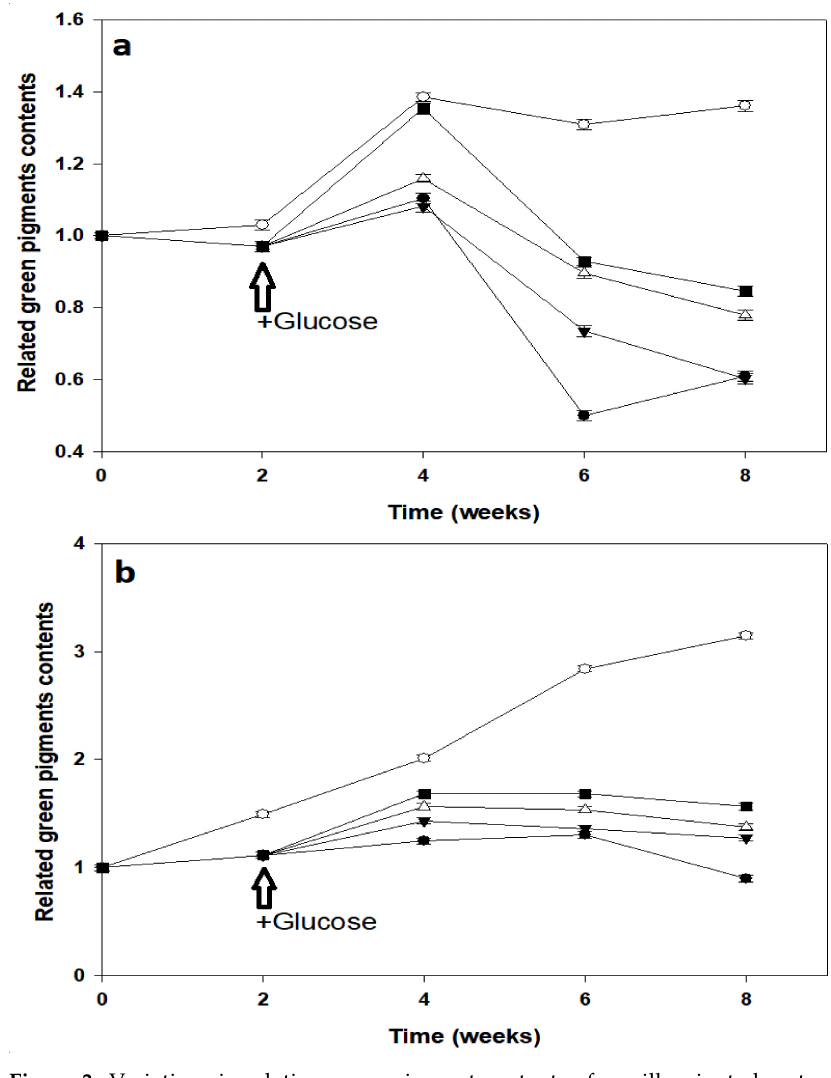
Figure 3. Variations in relative green pigment contents of pre-illuminated mature ( a ) and young ( b ) leaves of Pachira macrocarpa plants after feeding 0% ( • ), 2% ( (cid:72) ), 4% ( (cid:52) ), and 6% ( (cid:4) ) glucose in complete darkness and in a lighted condition ( ). Each data point represents the mean ± SD of five (cid:35) independent